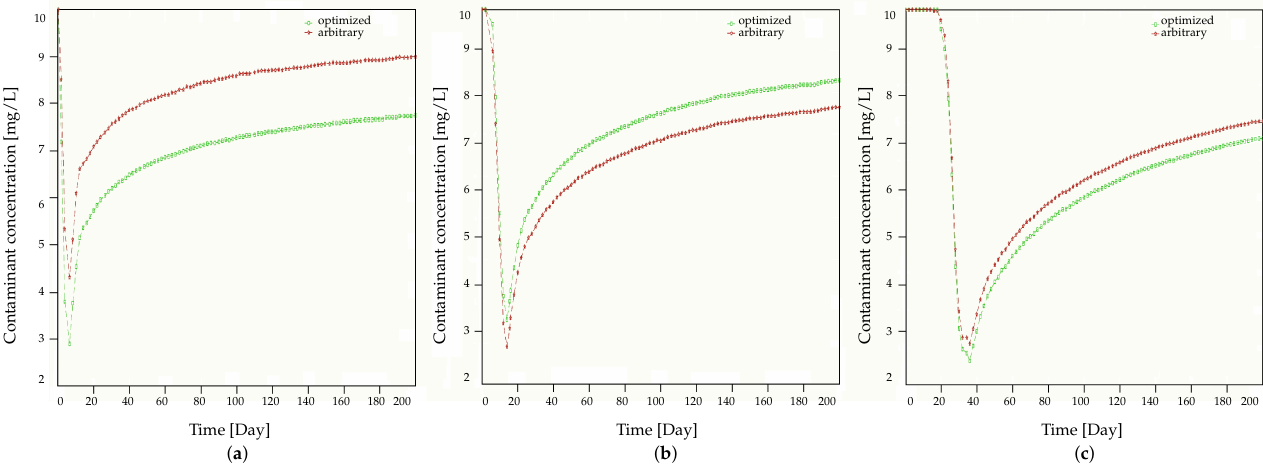
Figure 9. Comparison between contaminant concentration at observation points located at: ( a ) (36,10) m, ( b ) (60,15) m and ( c ) (75,10) m optimized and arbitrary location of the oxidant sources.